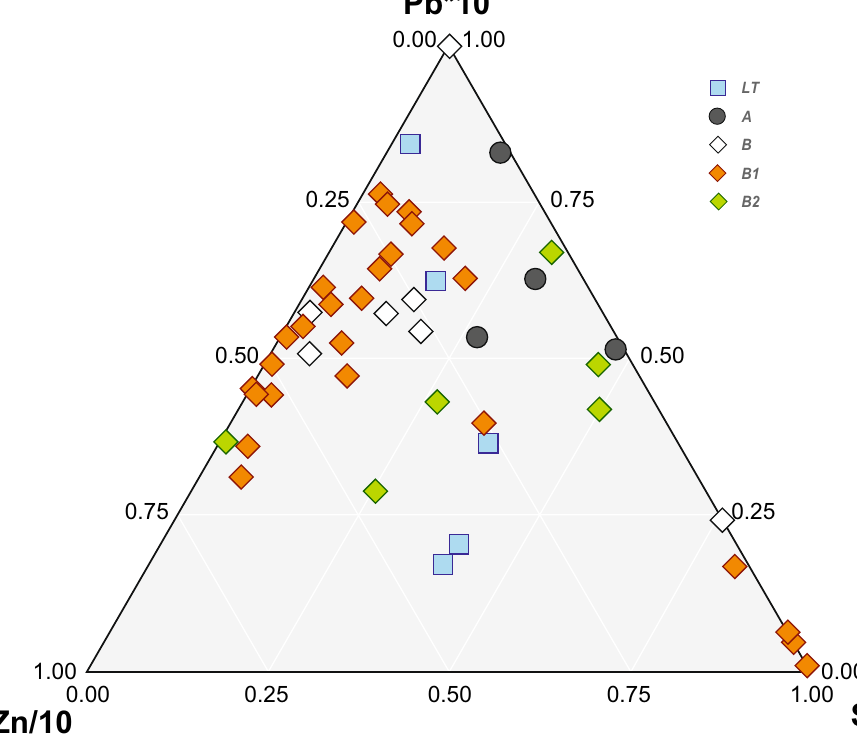
Figure 3. Ternary Pb–Zn-Sn plot for the Bohemian brass samples from this study categorised according to their dating. Zinc content is divided by a factor of ten, whereas the Pb content is multiplied by factor of ten. For categorisation according to the cultural groups see Suppl. Figure